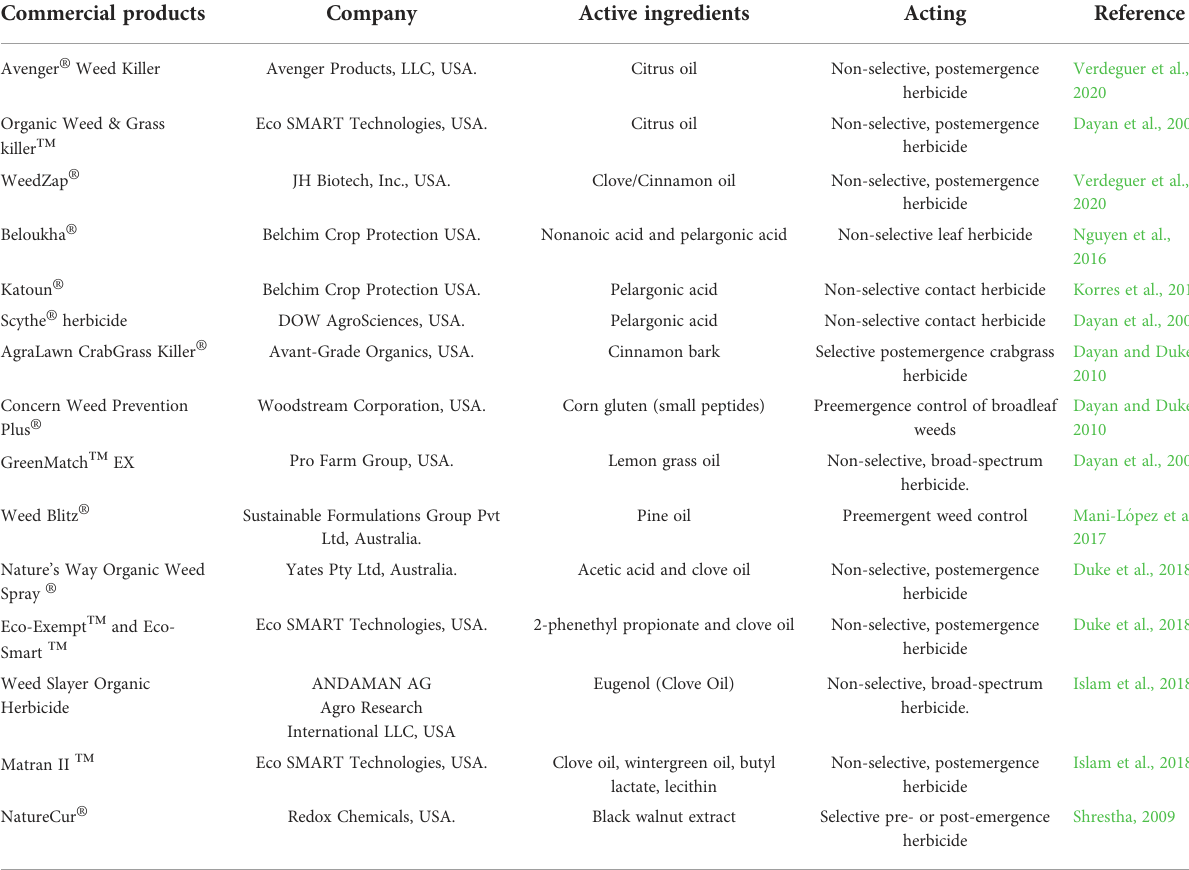
TABLE 3 Examples of commercial herbicides with allelochemicals as active ingredients.